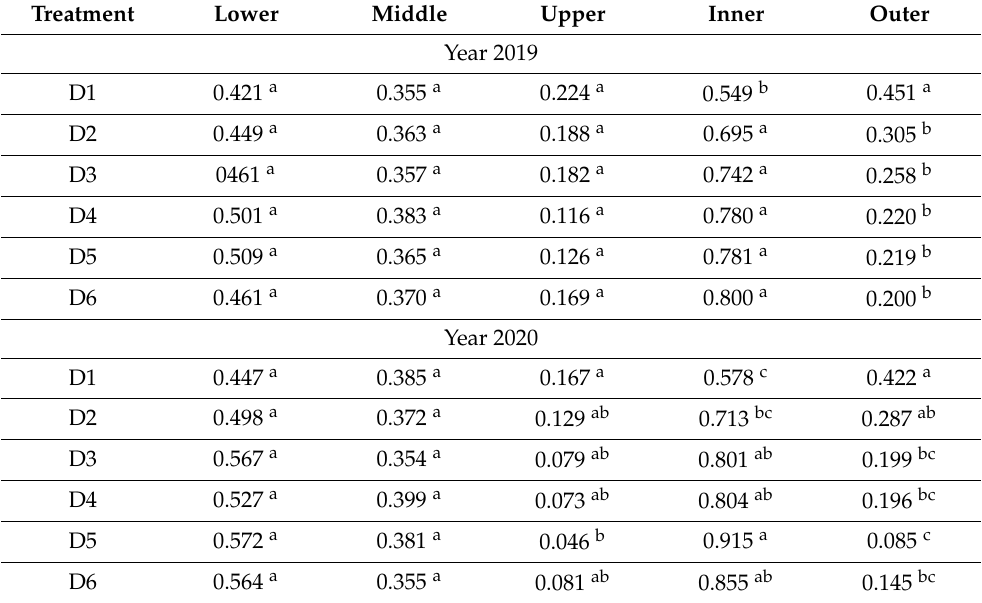
Table 5. The boll retention rate of different sections with different densities in 2019 and 2020.